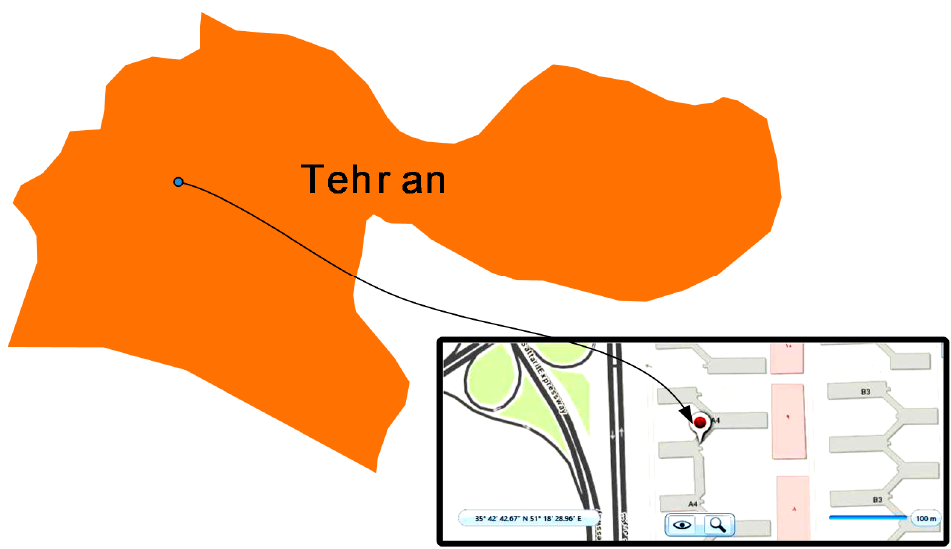
Figure 4. The location of the understudy residential household, Tehran, Iran.